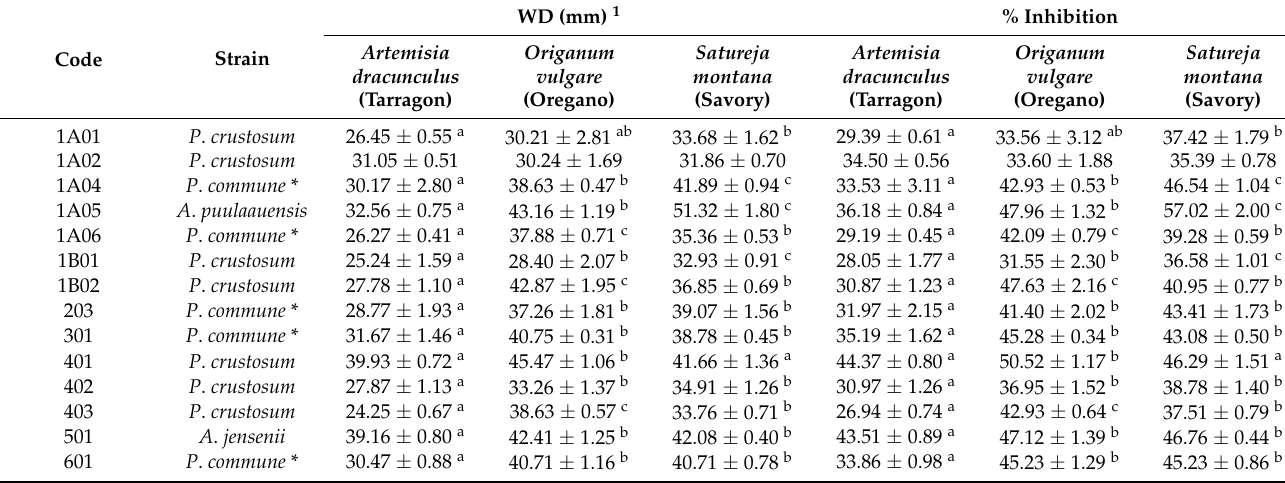
Table 4. Inhibition halos (mm) and percentage of inhibition (%) of essential oils against the isolated mold strains (mean ± sd).